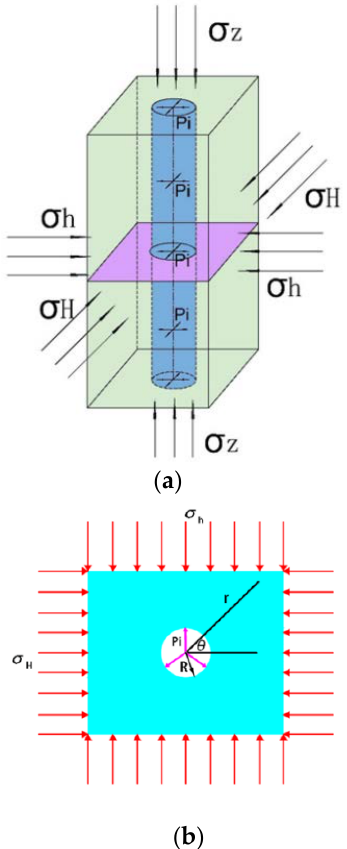
Figure 2. Stress distribution around the borehole. ( a ) 3D stress distribution at a certain depth; ( b ) stress distribution in the plane perpendicular to the axis of the ice borehole. (Chen, C., Polar Sci., in press, 2018)